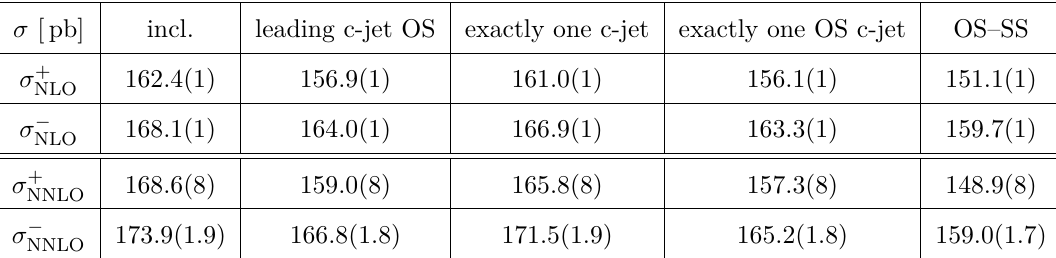
√ at s = 13 TeV. The upper plots show c